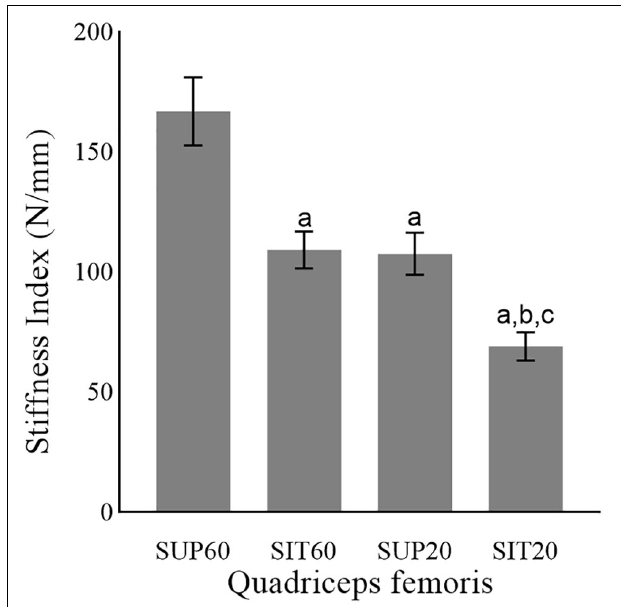
FIGURE 5 | The tendon-aponeurosis complex stiffness index of the quadriceps femoris in different muscle lengths according to hip and knee angles during neuromuscular electrical stimulation. Abbreviations: SUP60, lying with 60 ◦ of knee flexion; SIT60, seated with 60 ◦ of knee flexion; SUP20, lying with 20 ◦ of knee flexion; SIT20, seated with 20 ◦ of knee flexion. Statistically significant differences: a P < 0.05 vs. SUP60; b P < 0.05 vs. SIT60. c P < 0.05 vs. SUP20. Data are presented as mean and 95%